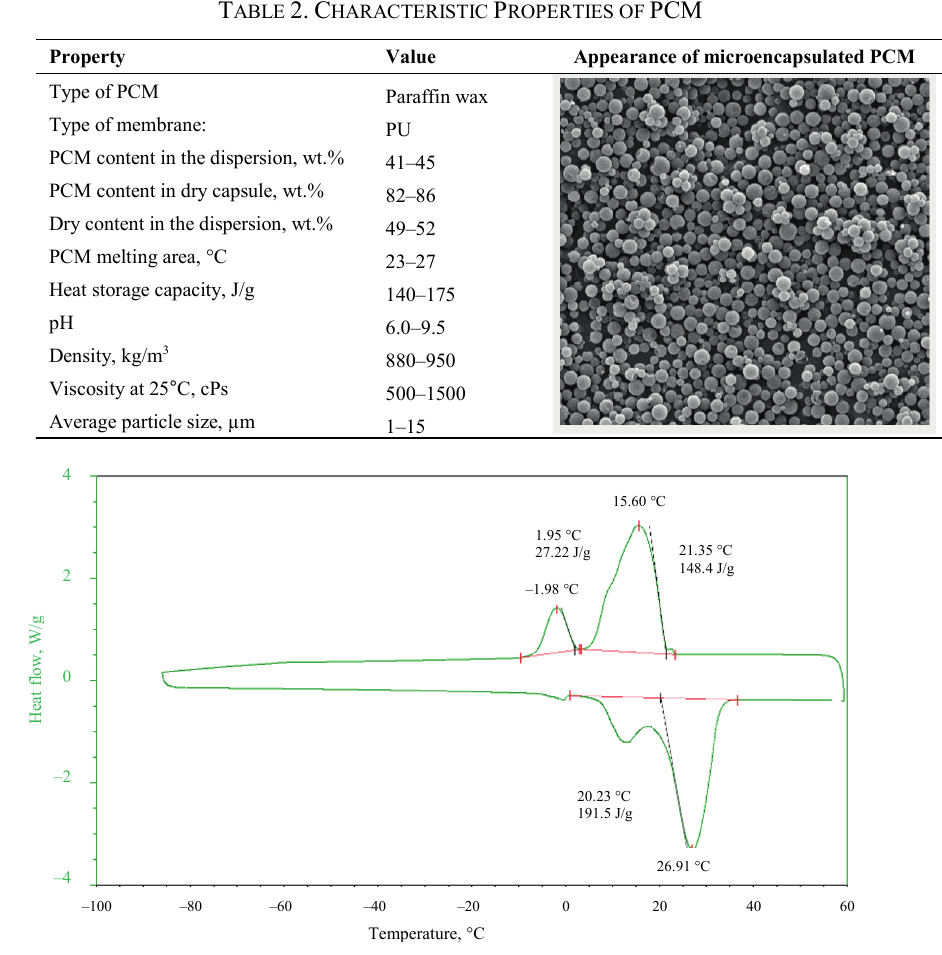
Table 2. For selected microcapsules, characteristic values of latent heat of fusion were from 140 to 175 kJ/kg.